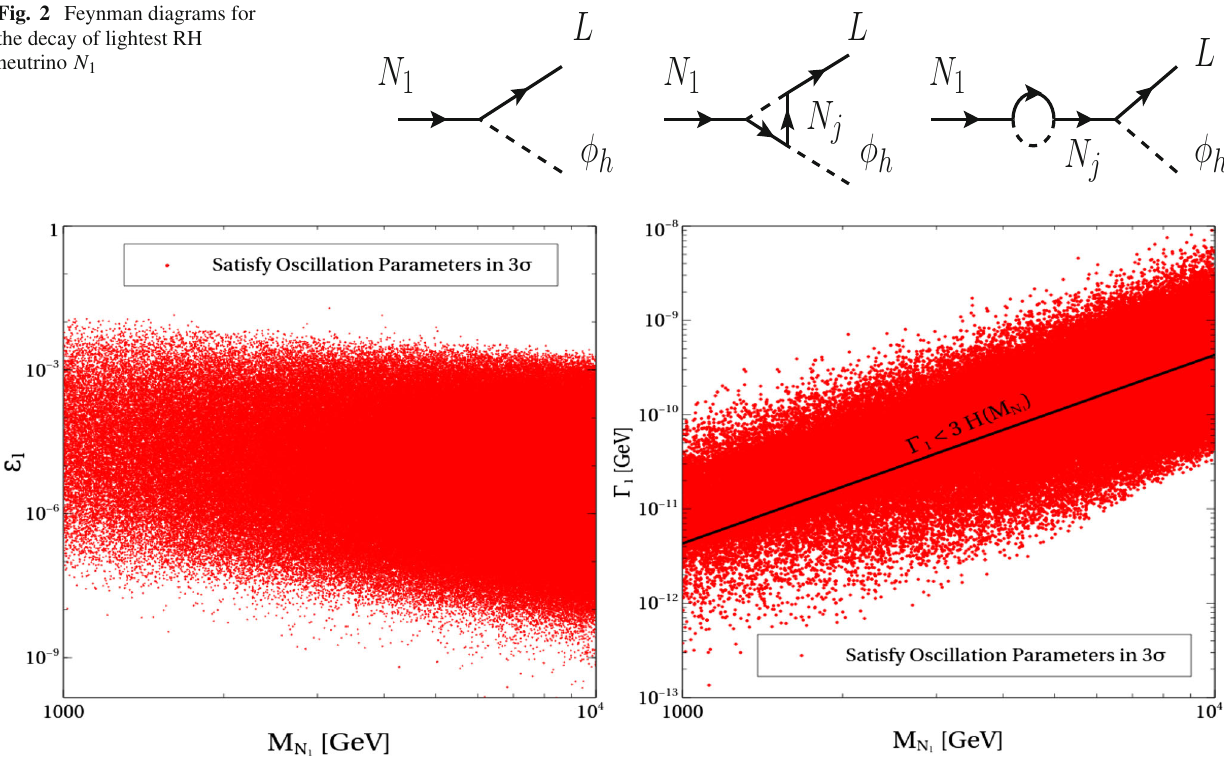
Fig. 2 Feynman diagrams for